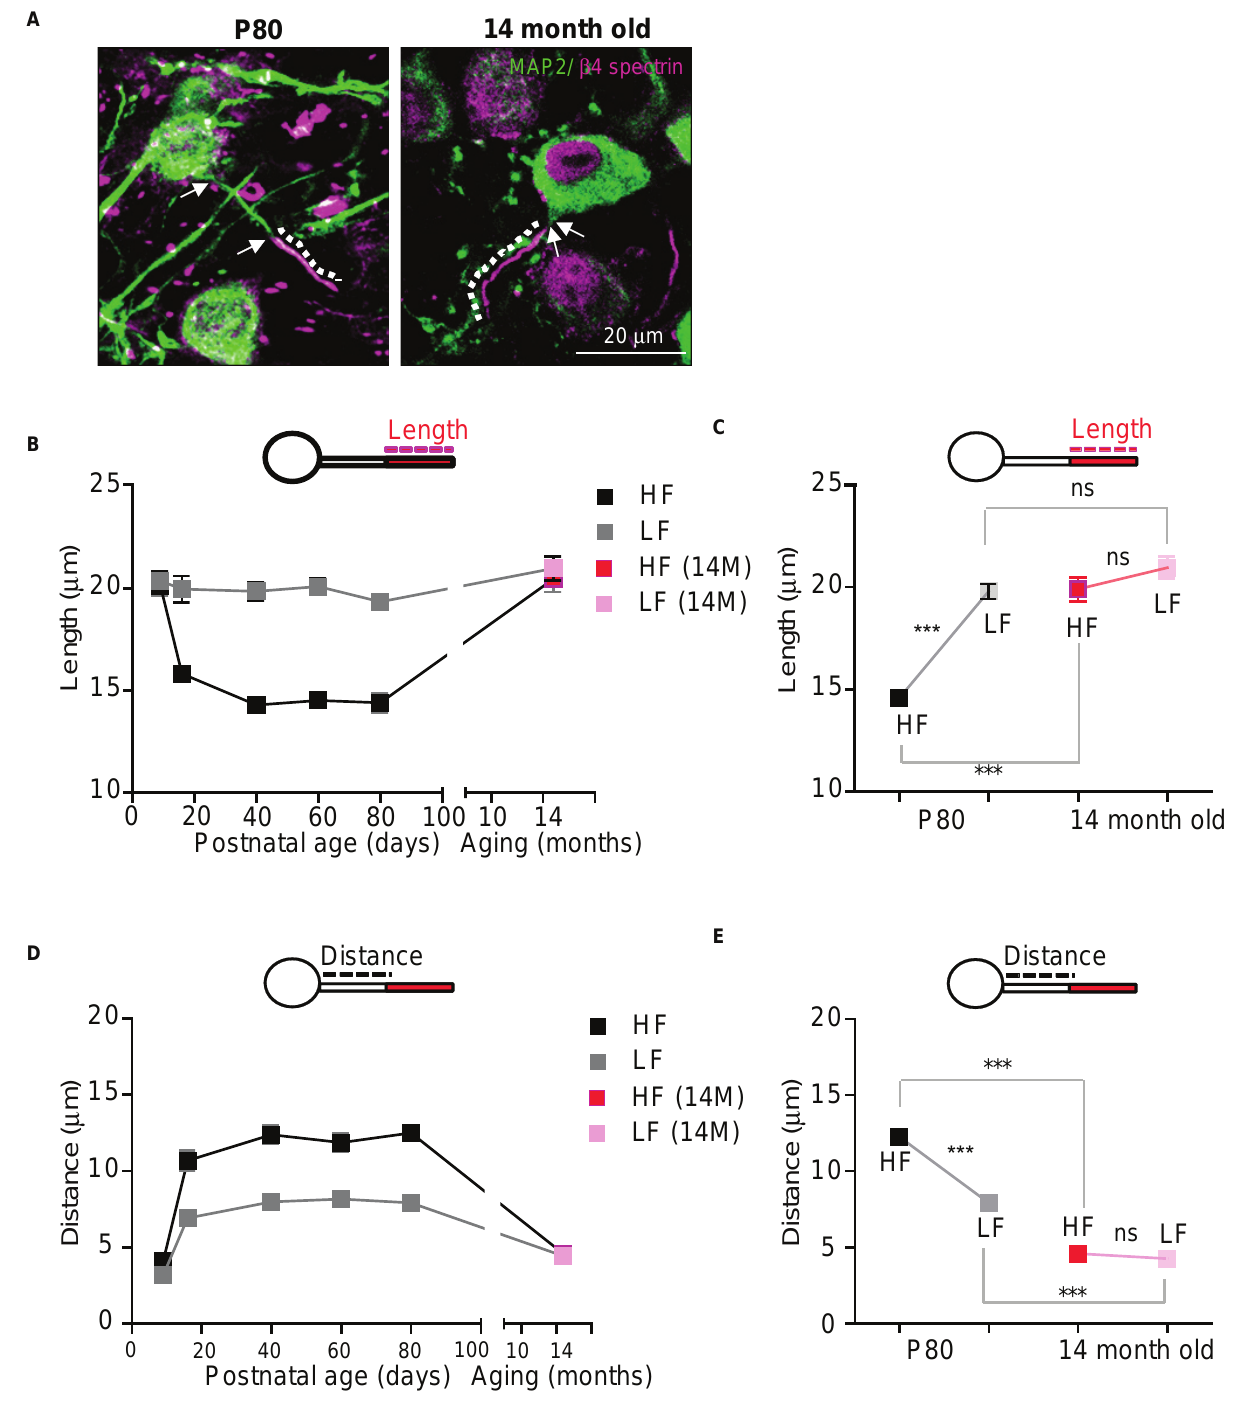
FIGURE 6 | The structural stability of the AIS of MNTB neurons is disrupted in aged mice. (A) HF neurons were immunostained with MAP2 and β 4 spectrin in adulthood (P80) and in an aged mouse (14-month-old; 14M). The dotted line and white arrow indicate AIS length and distance, respectively. (B) The plot of AIS length in HF (black) and LF (gray) neurons through lifetime from P9 to 14M and AIS length of HF (red) and LF (pink) in aged mice. (C) Tonotopy of AIS length in MNTB neurons from adult (at P80, black) and aged (14M, magenta) mice. ∗∗∗ p < 0.0001, Mann–Whitney U test. (D) The plot of AIS location in HF (black) and LF (gray) neurons through lifetime from P9 to 14M and AIS location of HF (red) and LF (pink) in aged mice. (E) Tonotopy of AIS location from adult (at P80, black) and aged (14M, red) mice. ∗∗∗ p < 0.0001, unpaired t -test.